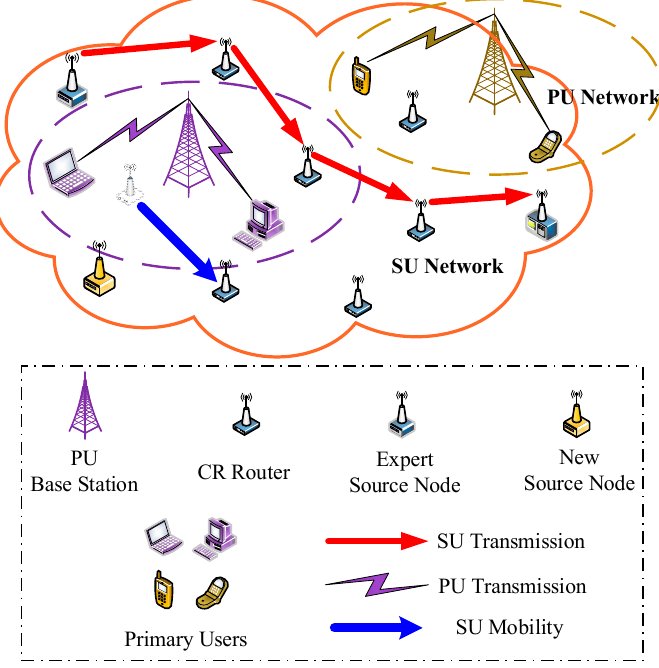
Figure 1. Multi-hop cognitive radio networking scenario.